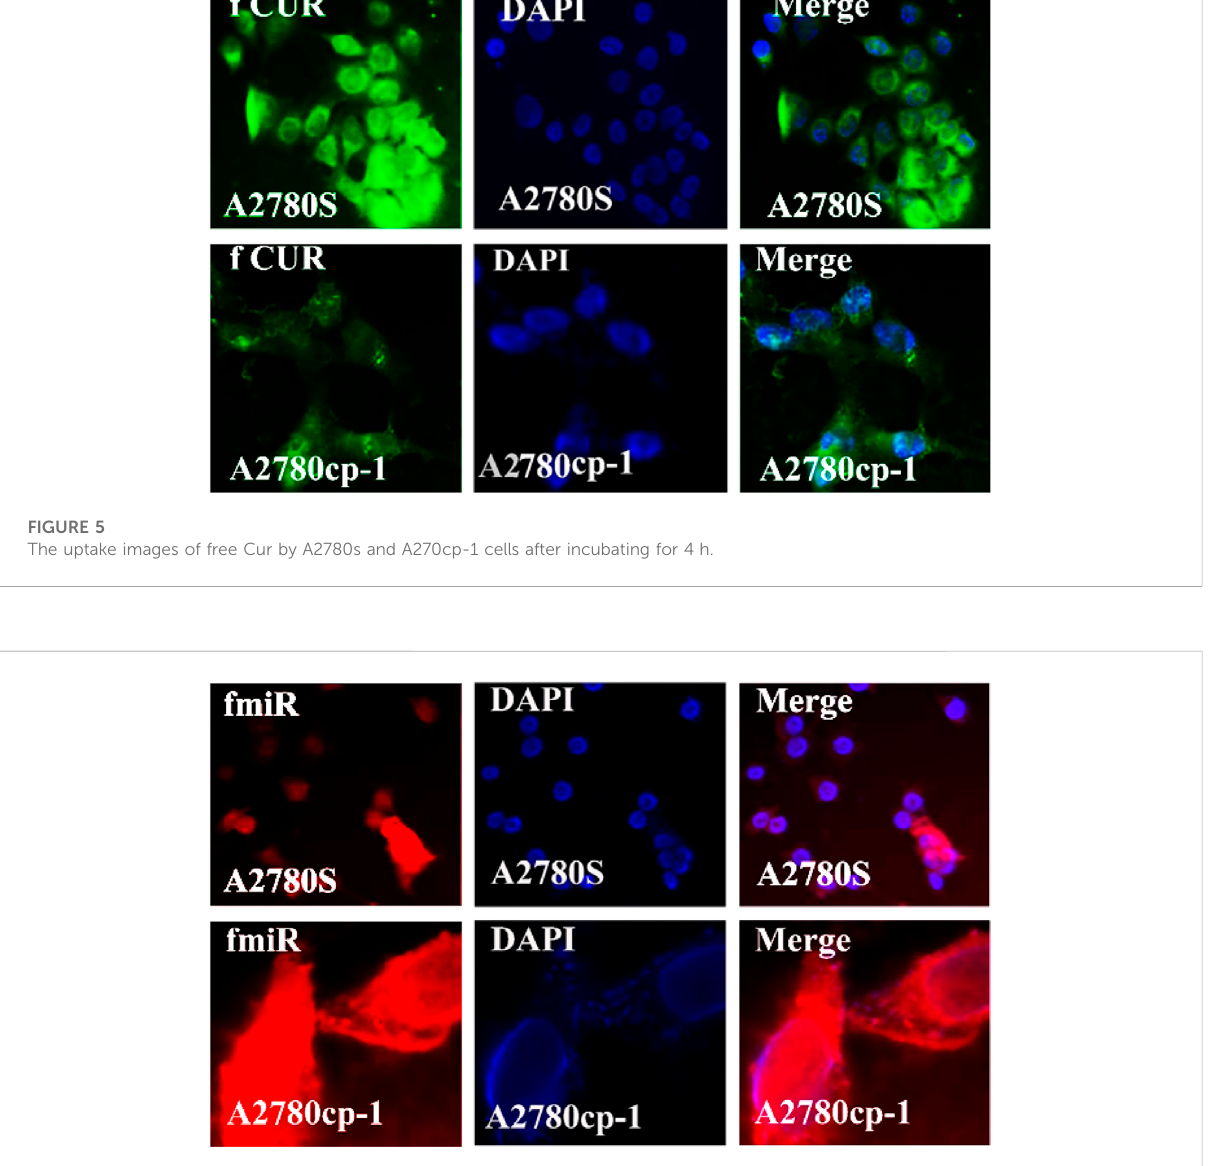
FIGURE 6 The uptake images of free miRNA by A2780s and A270cp-1 cells after incubating for 4